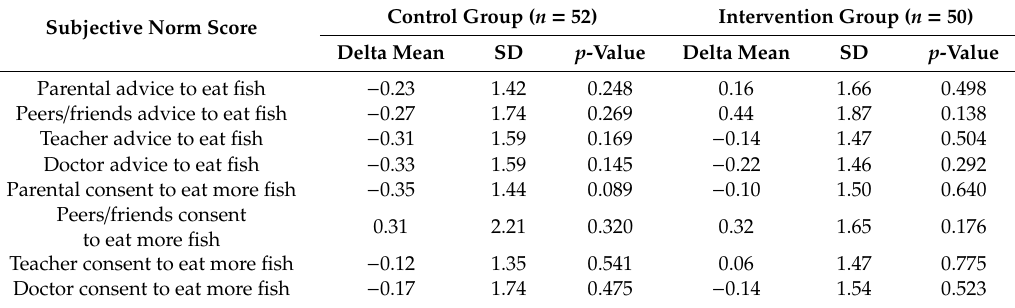
Table 4. Change in children’s subjective norm in fish consumption after 3 months of intervention. Control Group ( n = 52) Intervention Group ( n = 50) Subjective Norm Score Delta Mean SD p -Value Delta Mean